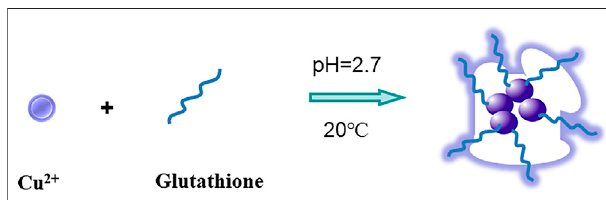
FIGURE 1 | Sketch map of the